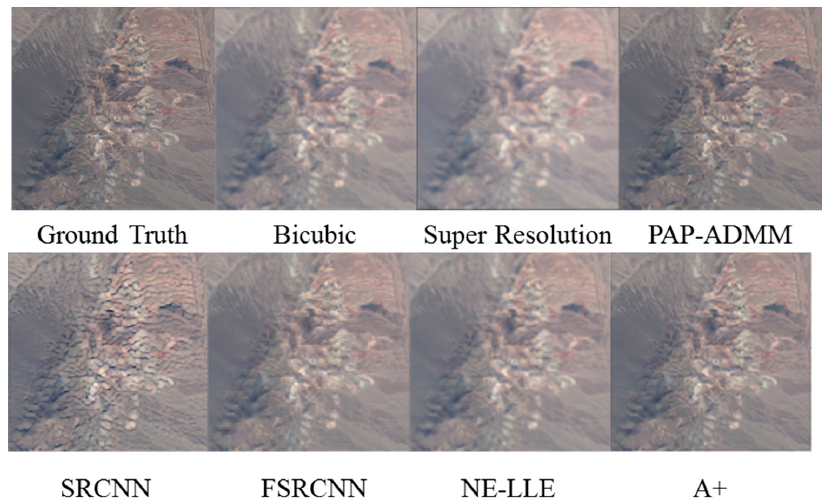
Figure 3. Comparison of seven single image super-resolution algorithms using the NASA AVIRIS data in the visible range.